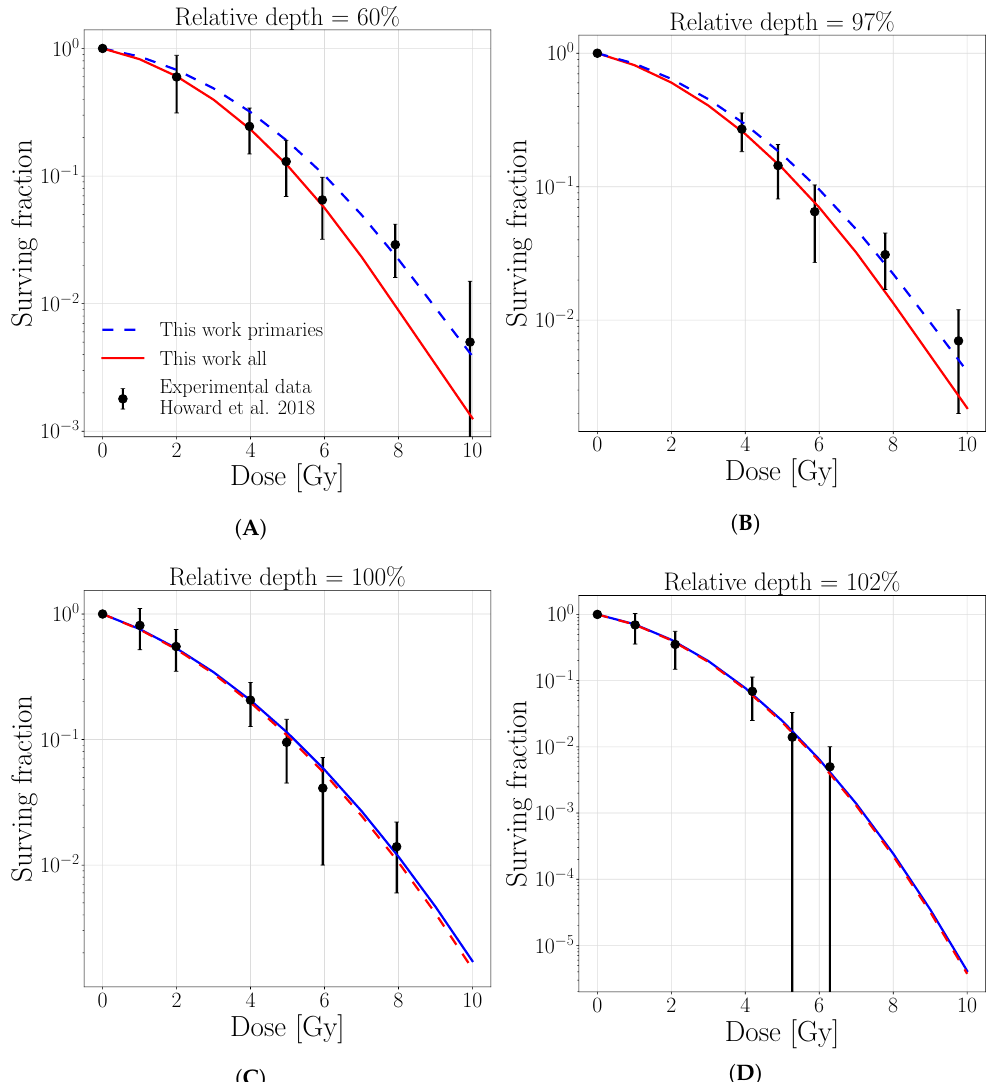
Figure 8. Surviving fraction for T98 cell line as a function of dose for an initial proton beam energy of 160 MeV at the depths of ( A ) 10.1 (60%), ( B ) 16.7 (97%), ( C ) 17.2 (100%), ( D ) 17.5 (102%). Solid lines represent linear interpolations for the surviving fraction evaluated with 1 MeV step, considering the contribution of only primary protons (dashed blue) or all particles (solid